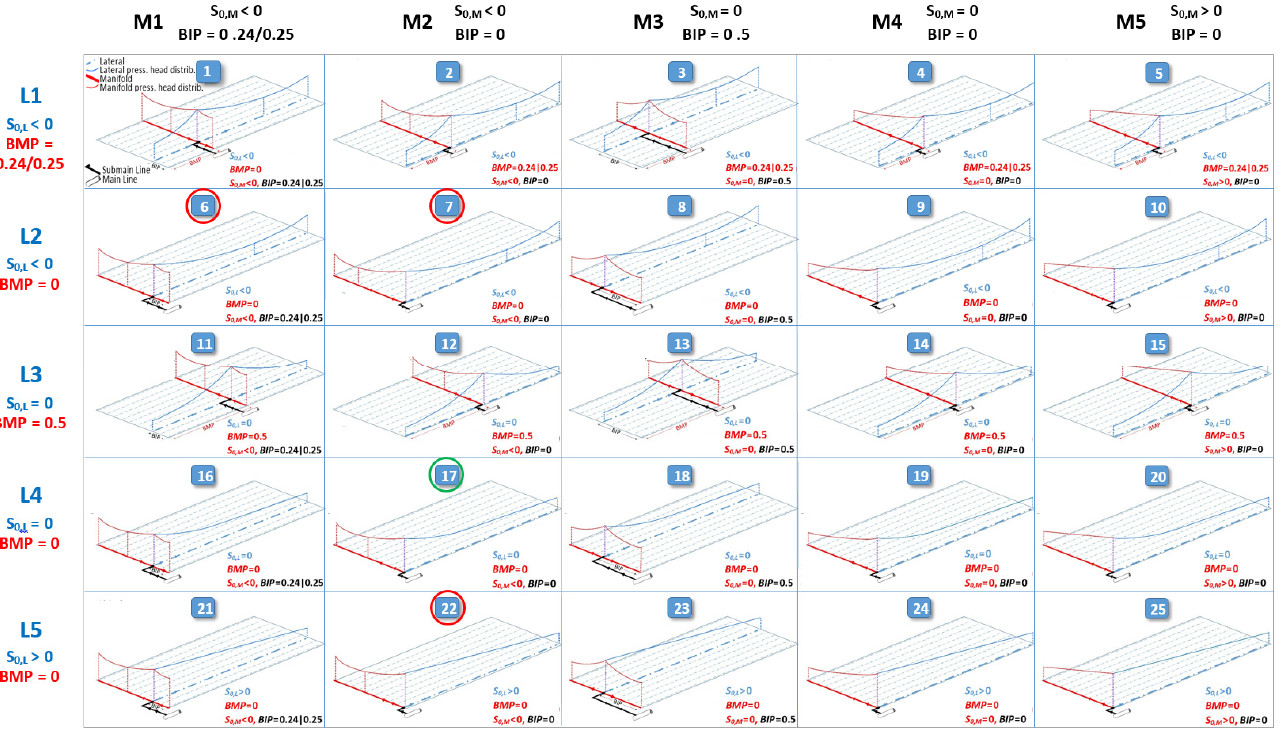
Figure 1. 25 irrigation sector layouts considered by IRRILAB, by varying the lateral slope ( S 0, L < 0, S 0, L > 0, S 0, L = 0), the best manifold position ( BMP = 0, 0.24, 0.5), the manifold slope ( S 0, M < 0, S 0, M > 0, S 0, M = 0), and the best inlet position ( BIP = 0, 0.24, 0.5). Qualitative pressure head distribution lines are represented for a lateral and for the manifold. Reprinted with permission from ref. [29], Copyright 2020, Elsevier (Amsterdam, The Netherlands).